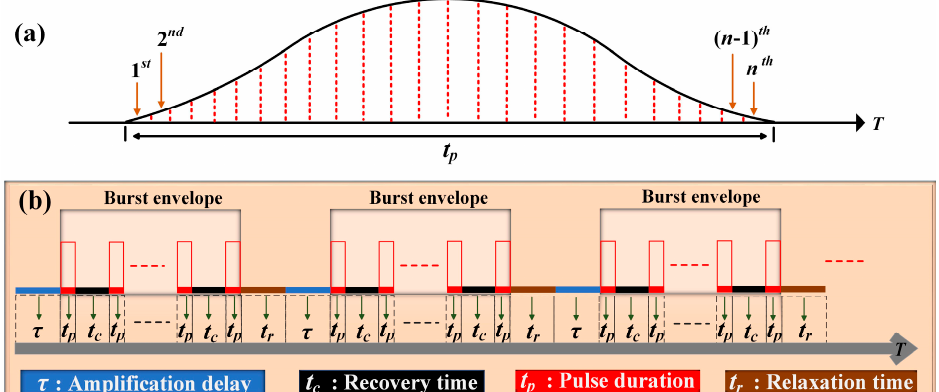
Figure 1. ( a ) Distribution of divided sub − pulses sequence for intra − burst individual pulse; ( b ) Schematic of time series distribution in burst-mode laser system.